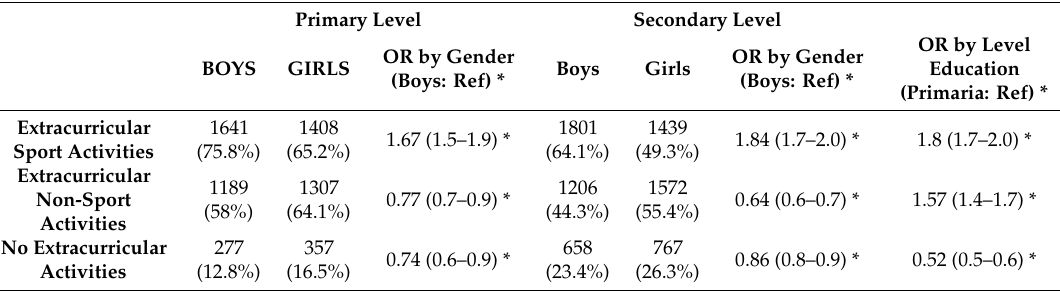
Table 1. Distribution of extracurricular classes by educational level.